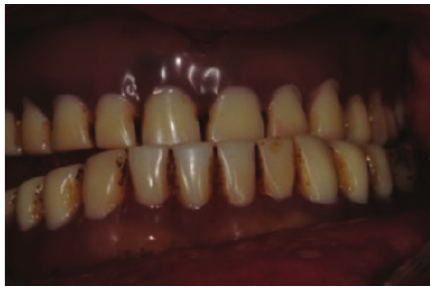
Figure 1: Initial dentures worn out with an altered